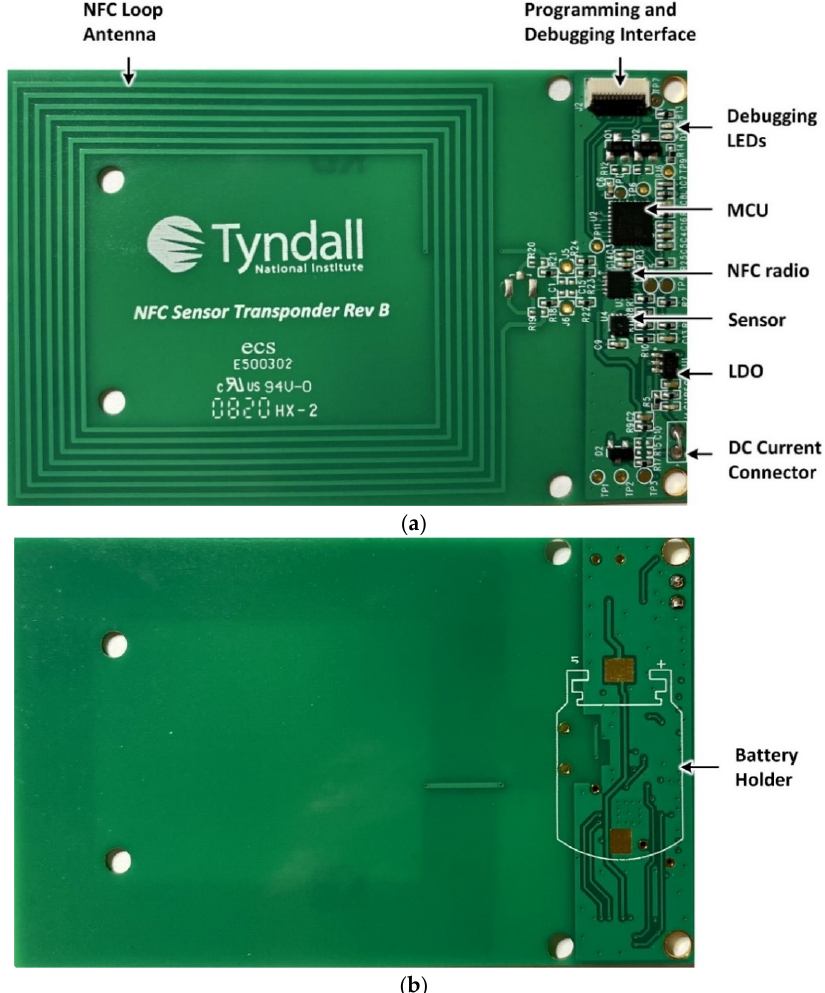
Figure 3. NFC sensor hardware prototype ( a ) Top side and ( b ) Bottom side.